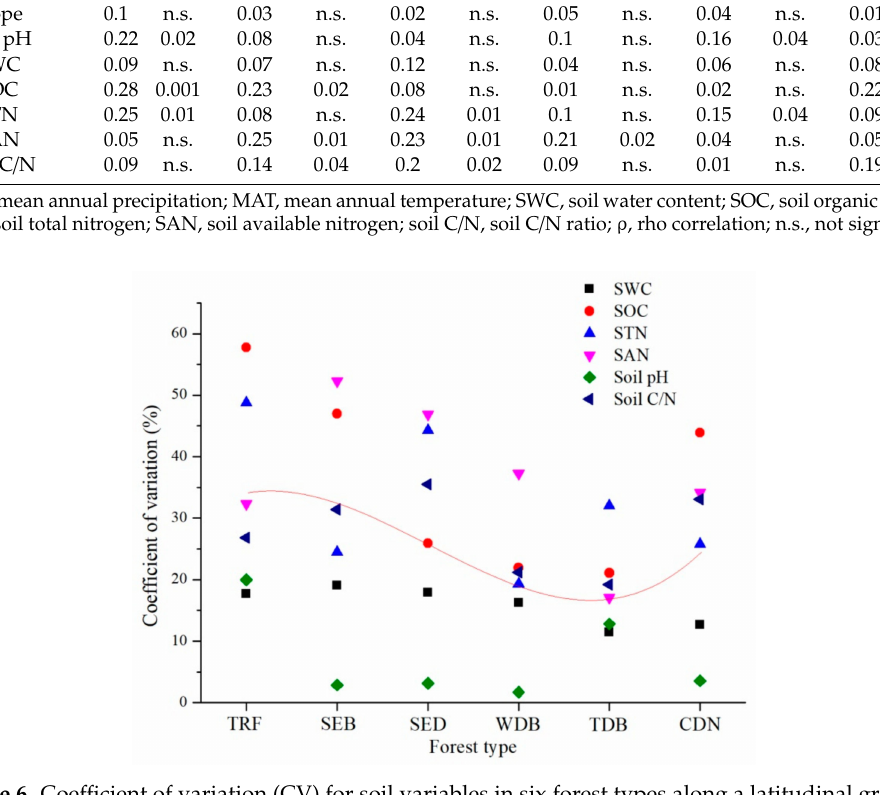
Figure 6. Coe ffi cient of variation (CV) for soil variables in six forest types along a latitudinal gradient. The higher variation means higher soil heterogeneity. The other CVs for climatic and topographic variables have no significant relationship to soil fungal β -diversity and are not shown in the figure.